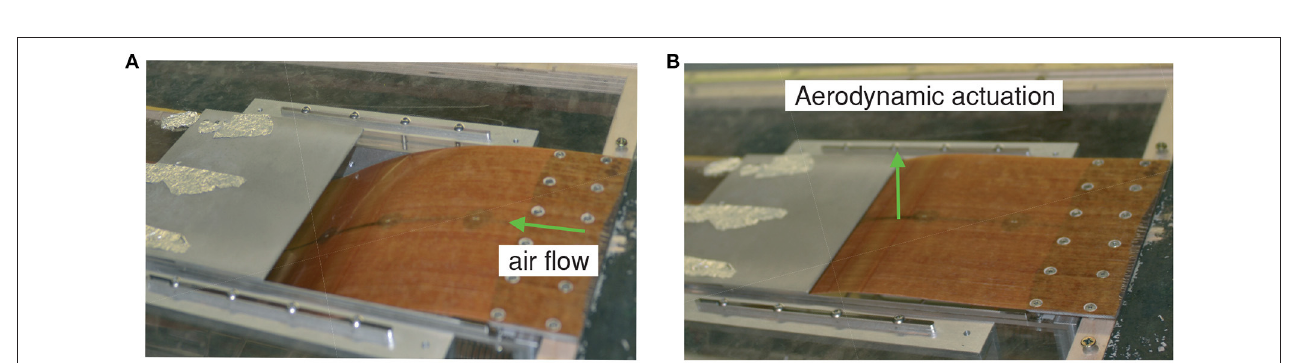
FIGURE 20 | Adaptive air inlet demonstrator. (A) Open state. (B) Closed configuration.